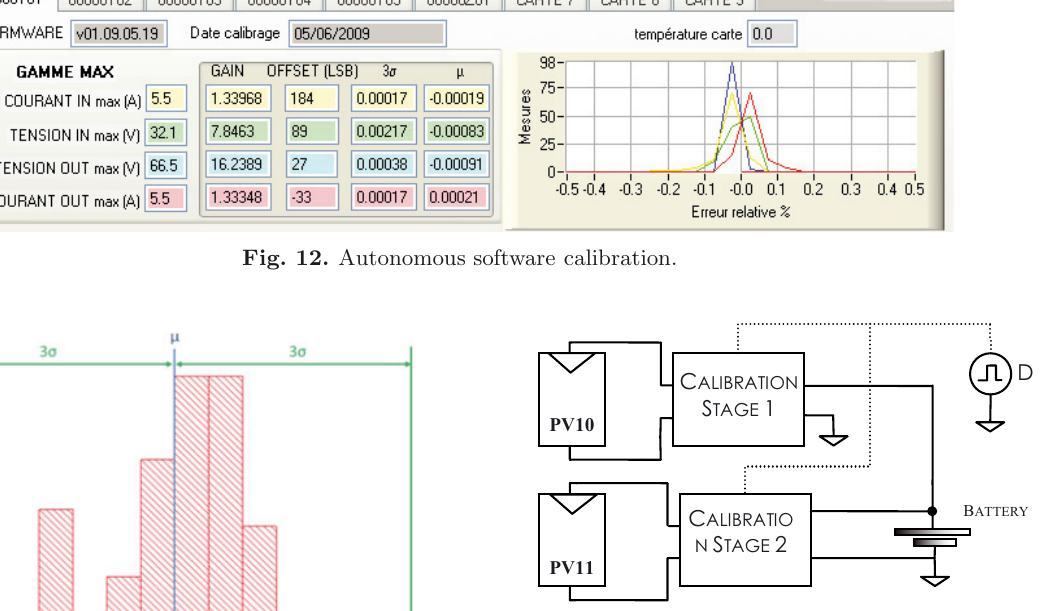
Fig. 14. Block diagram of the experimental set-up used to characterize the photovoltaic